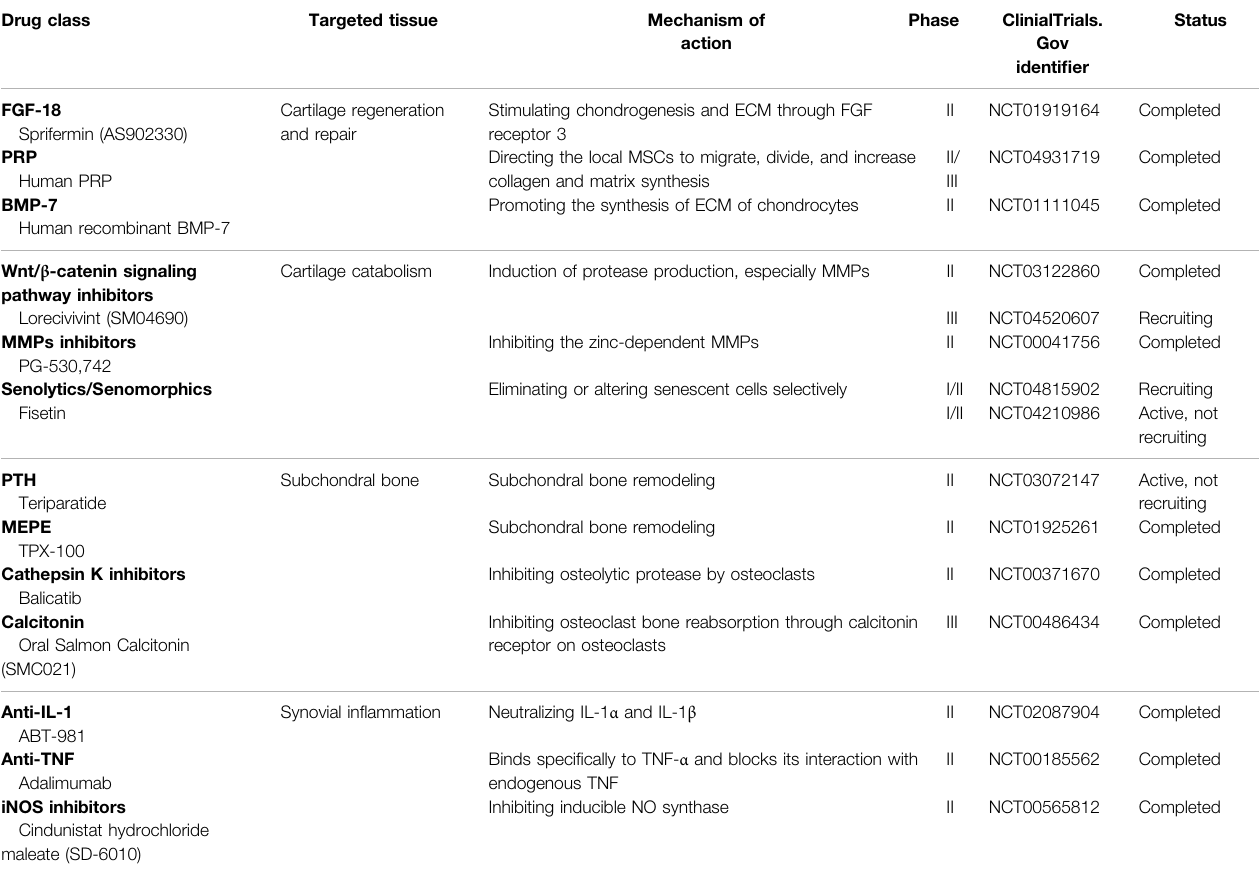
TABLE 1 | List of ongoing and completed clinical trials on potential